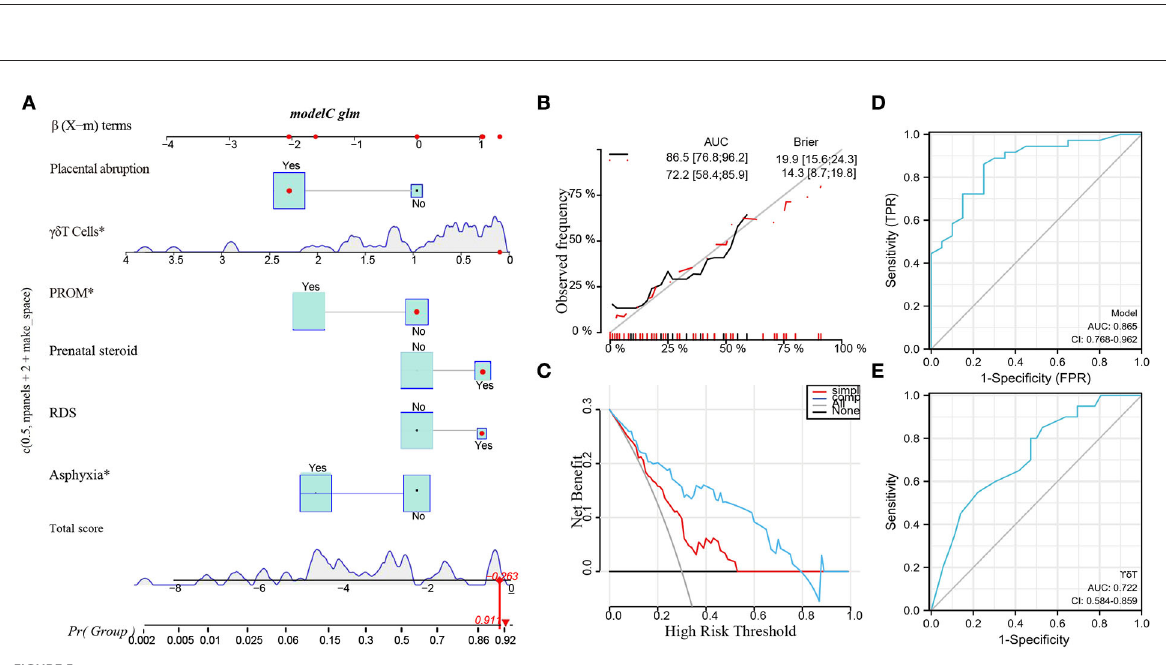
FIGURE5 Potential clinical utility of γδ T cells in Clinical Applications by Machine Learning. (A) Nomogram of the multivariate regression model. (B) The calibration curve of a multivariate regression model. (C) DCA curve of a multivariate regression model. (D) The AUC of ROC curves for the multivariate regression model was 0.865 (*** P < 0.000). (E) The AUC of ROC analysis of γδ T in cPVL was 0.722 (** P < 0.001). PROM, premature rupture of membrane; RDS, respiratory distress syndrome. * P <